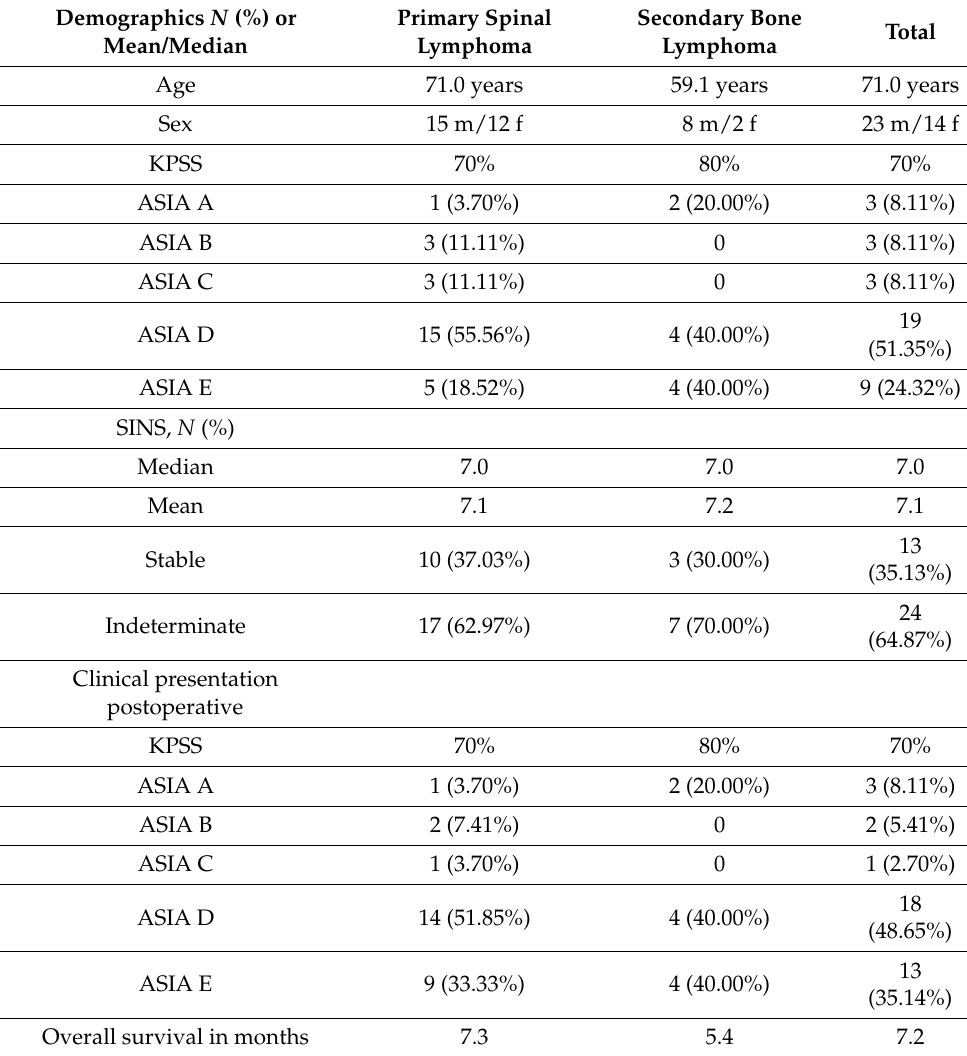
Table 1. Demographic and clinical data overview. KPSS: Karnofsky performance status scale; ASIA: American Spinal Injury Association; SINS: spinal instability neoplastic score. m: male; f: